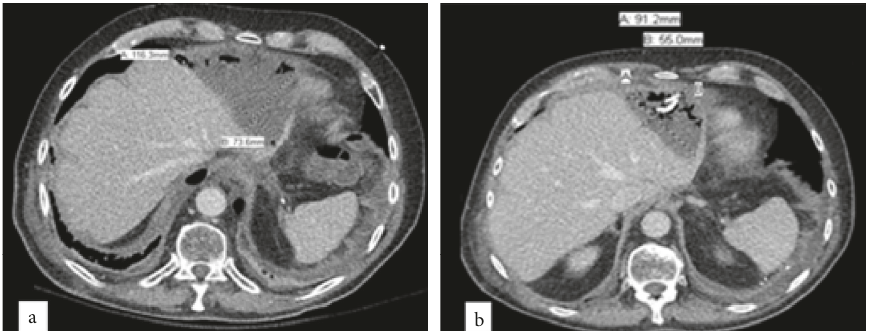
Figure 1: Computed tomography scan before starting antimicrobial therapy in Patient 1 shows a moderate volume of fluid and gas around the hepatic dome measuring approximately 11.6 × 7.4cm (a). Computed tomography at time of antimicrobial completion shows a complex fluid collection containing a few air bubbles inseparable from the left lobe of liver with pigtail drain with interval decrease in size to 9.1 × 5.5 cm (b).